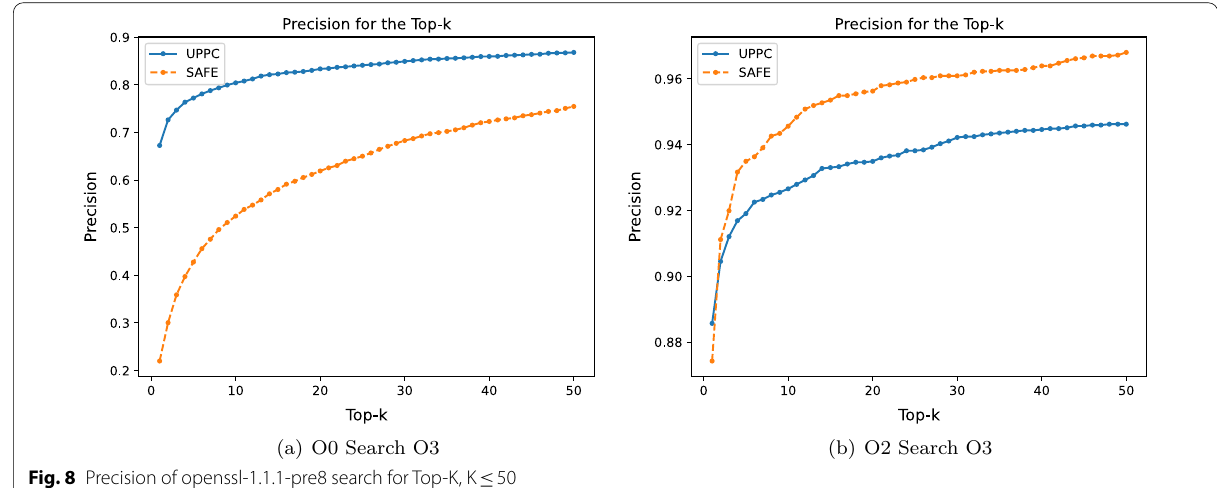
Fig. 8 Precision of openssl-1.1.1-pre8 search for Top-K, K ≤